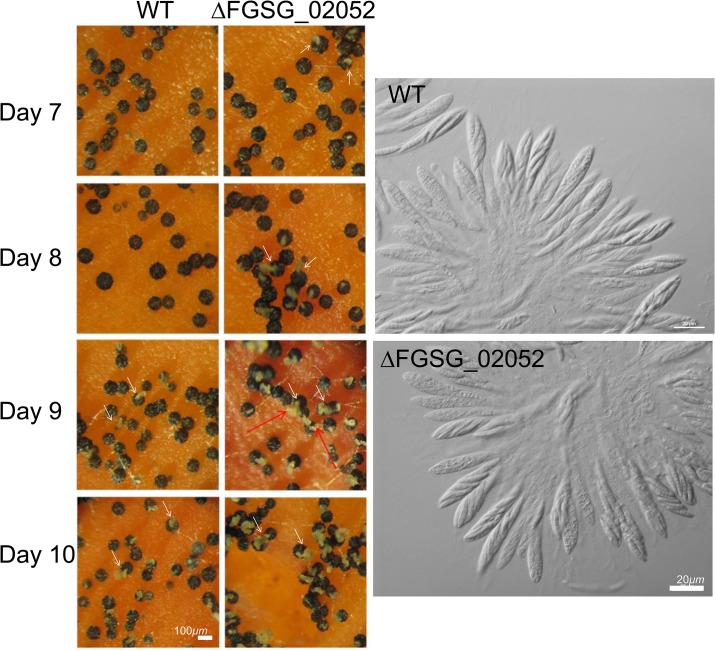
Formation of perithecia (left panels) and the morphology of asci and ascospores within a perithecium in the F. graminearum deleted for FGSG_02052 (ΔFGSG_02052) grown on carrot agar.WT, F. graminearum wild-type Z3643 strain; ΔFGSG_02052, a transgenic Z3643 strain lacking the FGSG_02052 gene. The perithecia formed 7, 8, 9, or 10 days after perithecia induction, and the asci and ascospores that developed within 8-day-old-perithecium were observed through a dissecting microscope (left panels) and differential interference contrast microscope (right panels), respectively. The cirrhi production from the perithecia was indicated by arrows. Scale bars = 100 μm for perithecia and 20 μm for asci/ascospores.